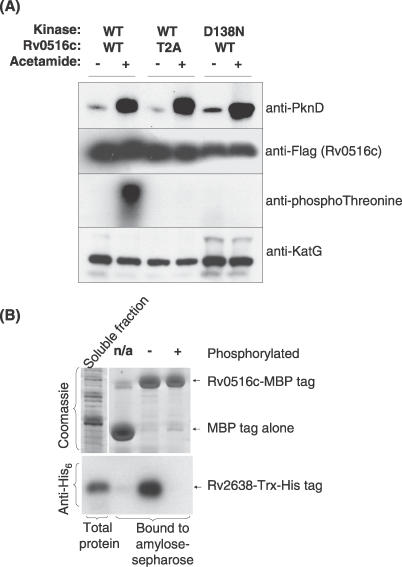
PknD Phosphorylates Rv0516c on Thr2 In Vivo, and This Phosphorylation Blocks Binding to Another Sigma Factor Regulator(A) Western blot of lysates of Mtb strains expressing full-length PknD under the control of an acetamide-inducible promoter and constitutively expressing Rv0516c with a C-terminal, FLAG epitope tag. As controls, the kinase was rendered inactive (D138N) or the Rv0516c phosphorylation site was mutated (Thr2Ala [T2A]). The active (but not the mutant) PknD phosphorylated the overexpressed WT Rv0516c. The levels of endogenous proteins were too low to detect phosphorylated Rv0516c in this experiment. KatG was detected with antibodies as a loading control. Rv0516c (but not the Thr2Ala mutant) was phosphorylated upon WT PknD induction.(B) Phosphorylation on Thr2 abolished binding to Rv2638. Equal amounts of cell lysates overexpressing Rv2638 were incubated with pre-phosphorylated (lane 4) or unphosphorylated (lane 3) Rv0516c. As a control, Rv2638 binding to the purification tag alone was evaluated (lane 2). Protein staining was used to insure that equal amounts of recombinant protein were used as bait in each reaction, and bound Rv2638 was visualized by Western blotting with antibodies against the His6 tag. Total soluble protein before incubation with the amylose-Sepharose (lane 1) indicated the presence of Rv2638. Only unphosphorylated Rv0516c bound the anti-anti–sigma factor, Rv2638.